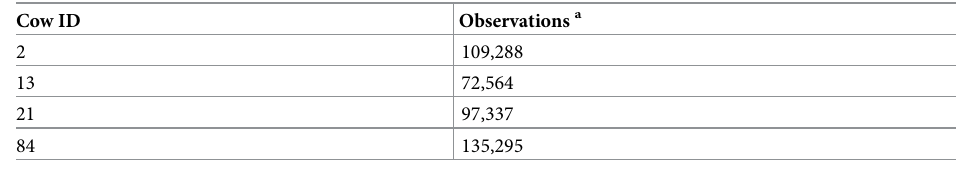
Table 2. Number of observations per cow.